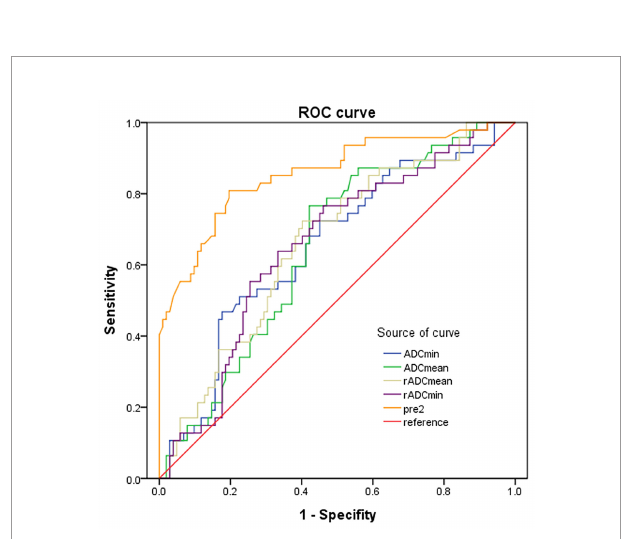
FIGURE 7 | ROC curves of ADC indicators and combined predictors for distinguishing IDH mutants from IDH-wild type